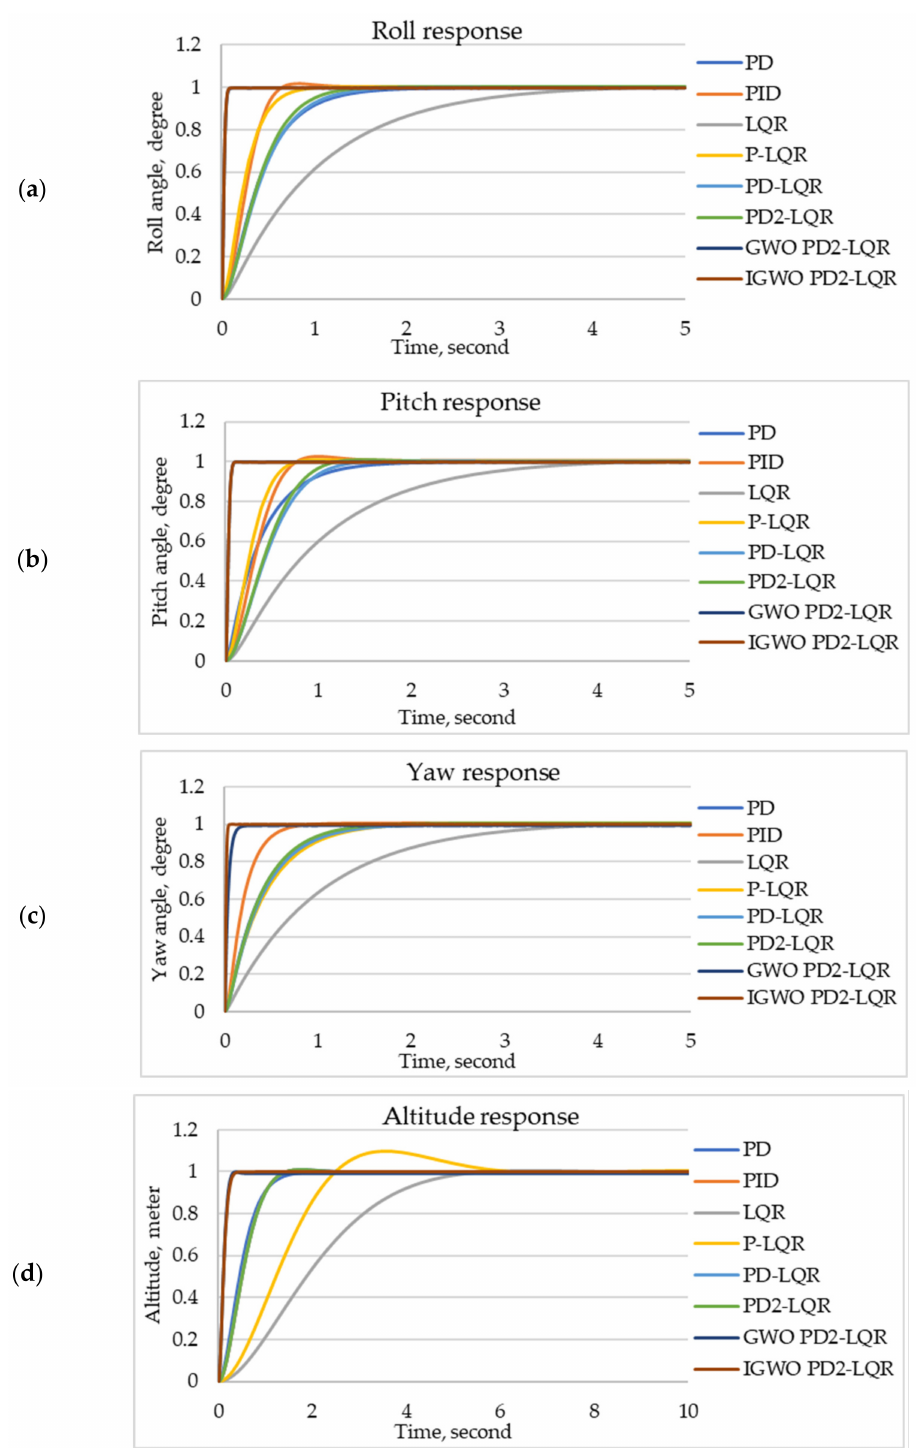
Figure 4. Step response of the system, ( a ) roll, ( b ) pitch, ( c ) yaw, and ( d ) altitude motion. Regarding the RMSE, the IGWO PD2-LQR controller produces the lowest value with 0.2207, 0.2224, and 0.1751 in roll, pitch, and yaw motion, respectively, while the PD2-LQR controller is the best in altitude motion with 0.3223. The highest error is produced by the LQR controller (0.4562, 0.4567, and 0.3983) in roll, pitch, and yaw motions, while the IGWO PD2-LQR controller (0.3754) is worst in altitude motion. Although the IGWO PD2-LQR controller is the worst in altitude motion, the difference with the lowest error is only